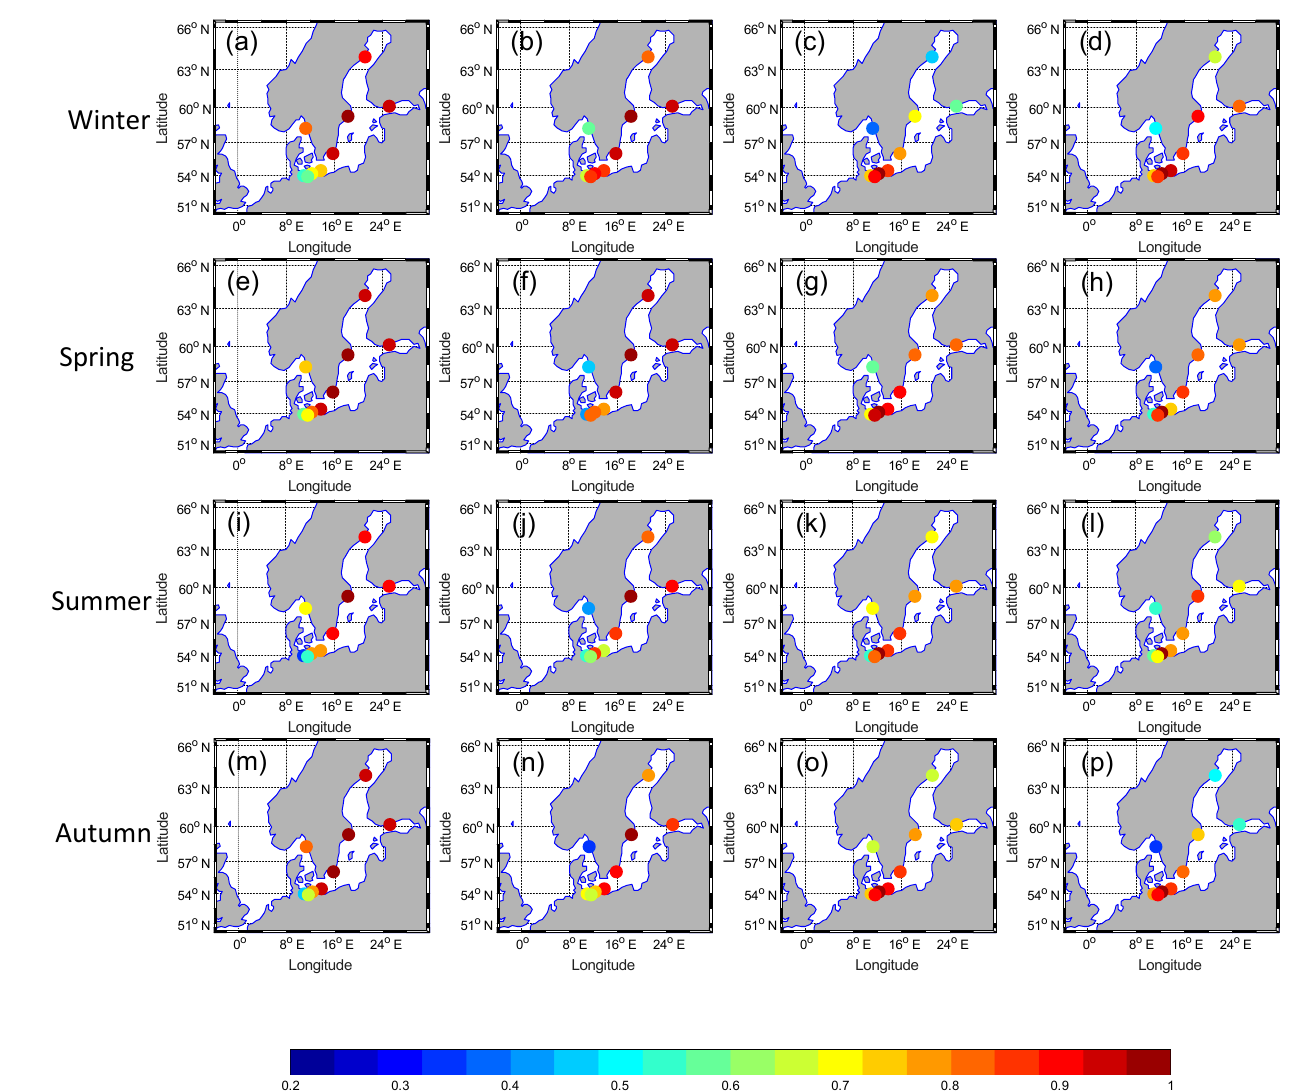
Figure 5. Correlation between sea level at two representative tide gauges (Stockholm and Warnemünde) and at the rest of the tide gauges based on decadal trends. First (last) two columns present the correlation between Stockholm (Warnemünde) and the other tide gauges. For each tide gauge, the left (right) column shows the correlations obtained with the observed (residual) record. The maps are ordered as follows: winter: first row ( a–d ), spring: second row ( e–f ), summer: third row ( i–l ), and autumn: last row ( m–p ). The 95% significance level is ± 0.19 for this record length. Note that the correlation scale ranges from 0.2 to